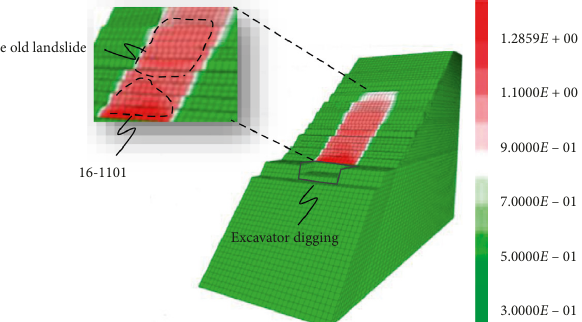
Figure 19: “16-1101 landslide” instability displacement